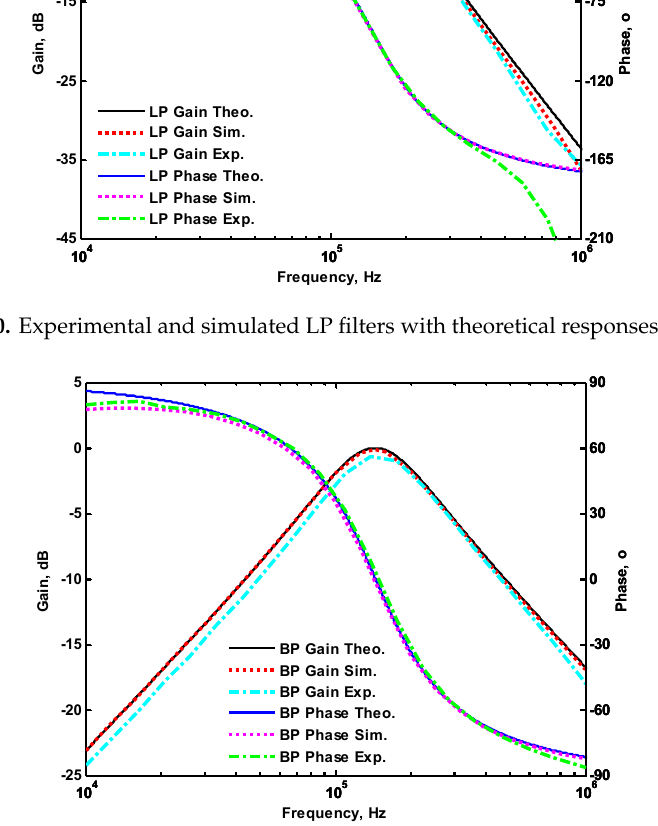
Figure 11. Experimental and simulated BP filters with theoretical responses in case II.